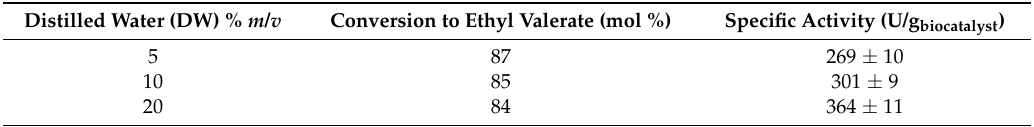
Table 2. Effect of water presence on the conversion of valeric acid to ethyl valerate and on the specific activity of prepared biocatalysts.